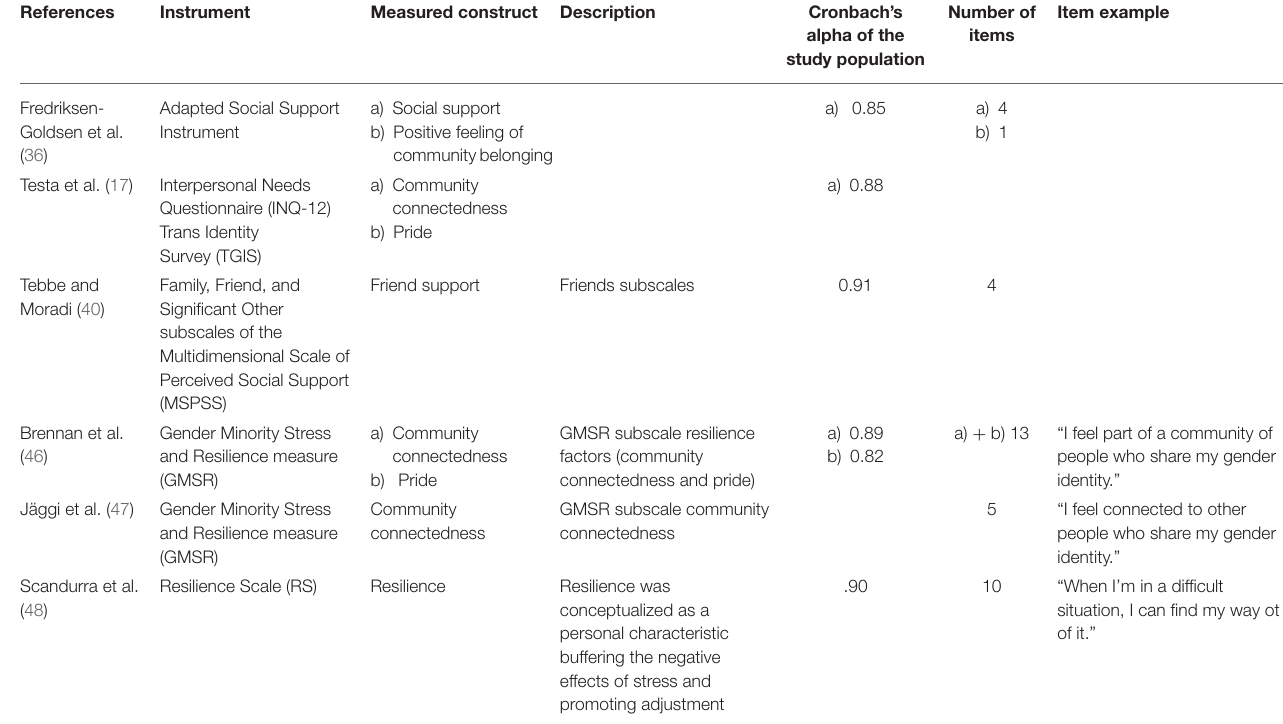
TABLE 7 | Description of studies’ instruments to assess protective